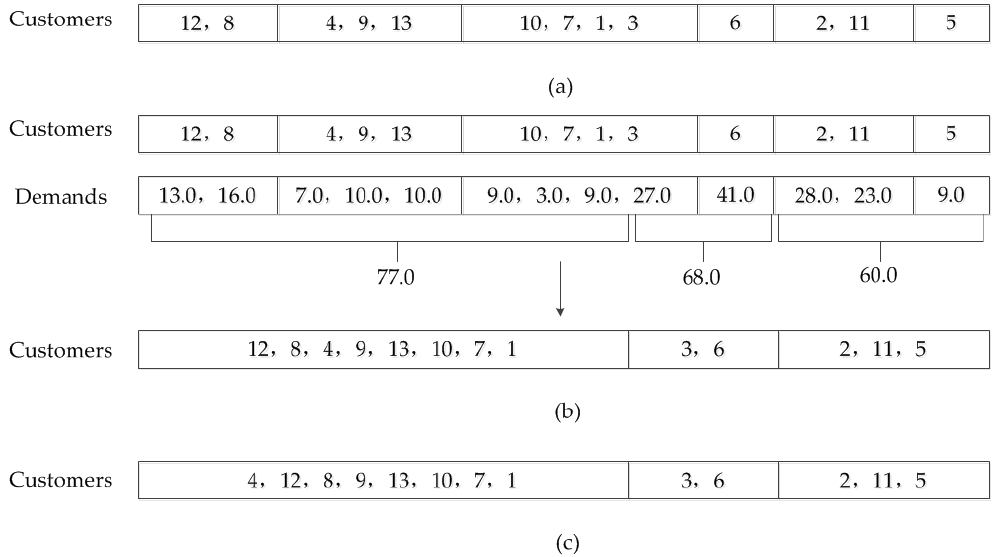
Figure 4. ( a ) One sector sequence result; ( b ) Illustration of the method of grouping the sectors; ( c ) The rearranged order using CWS method.